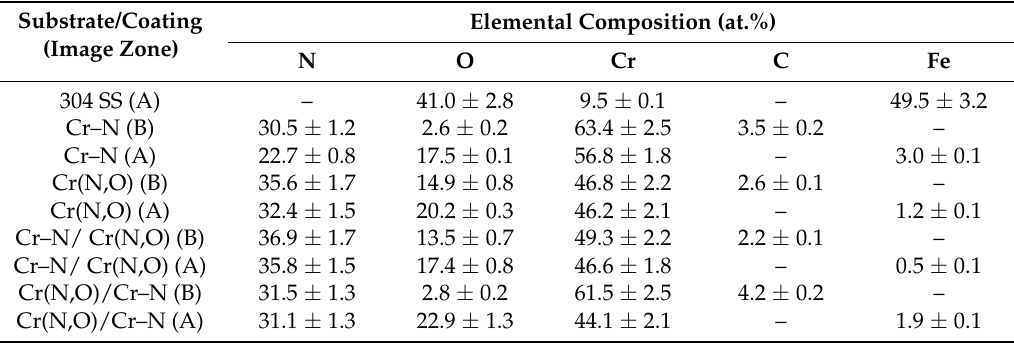
Figure 12. Energy dispersive X-ray spectrometry (EDS) mapping micrographs of the Cr-based coatings after the corrosion test. Table 5. The elemental composition of the investigated specimens before (B) and after (A) the corrosion test in the areas shown in Figure